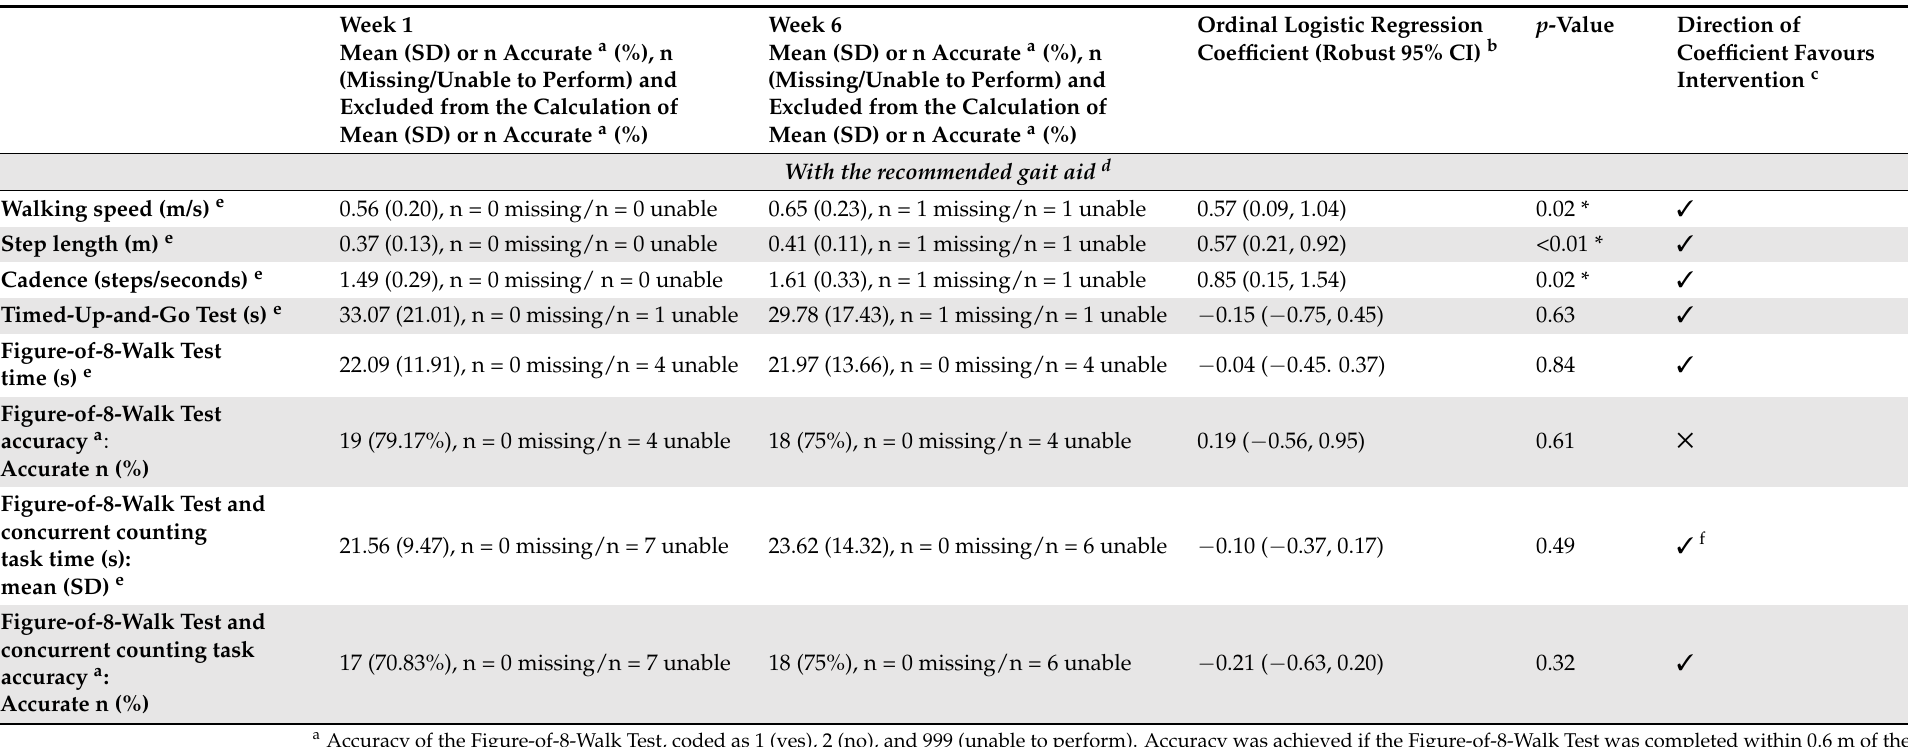
Figure-of-8-Walk Test and